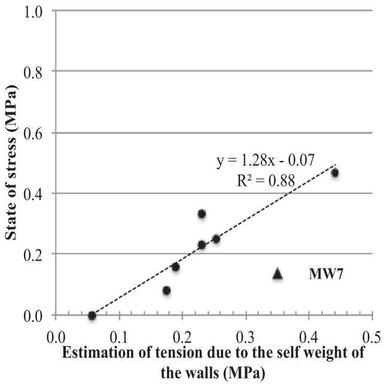
Influence of self-weight on the state of stress of tested walls.